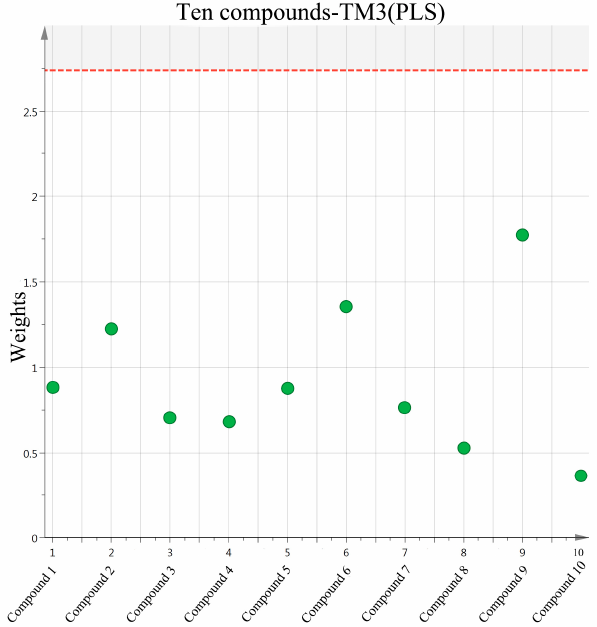
Figure 5. Model e ff ect weights of the ten compounds on Figure 5. Model effect weights of the ten compounds on TM3.